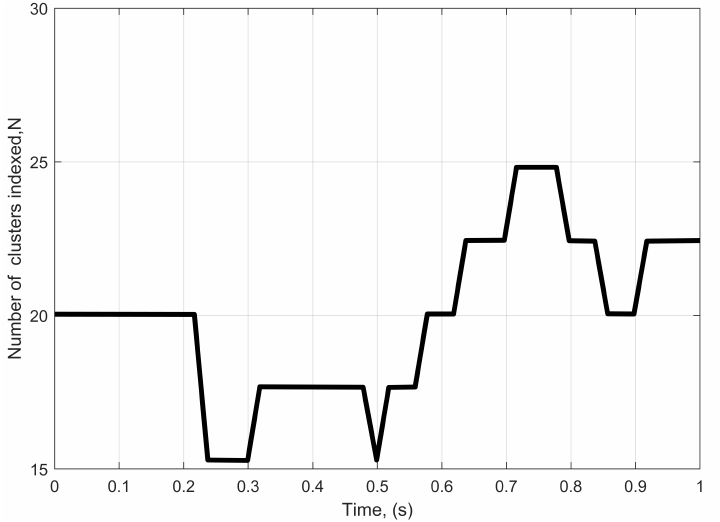
Figure 2. The death–birth process of the total number of clusters versus